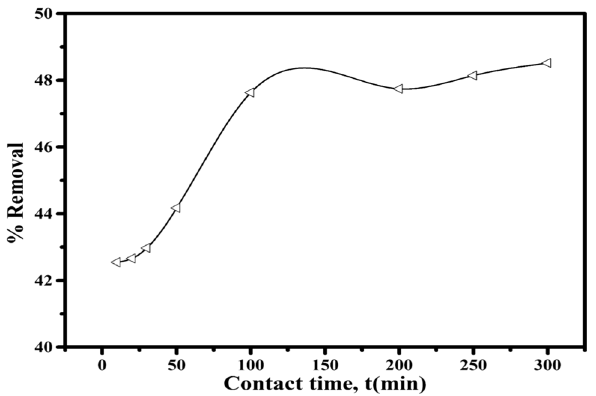
Fig. 6 Impact of contact time for the separation of MB dye on the surface of PBF at optimum conditions (pH 6, PBF dose 1 g, MB con- centration 100 ppm)